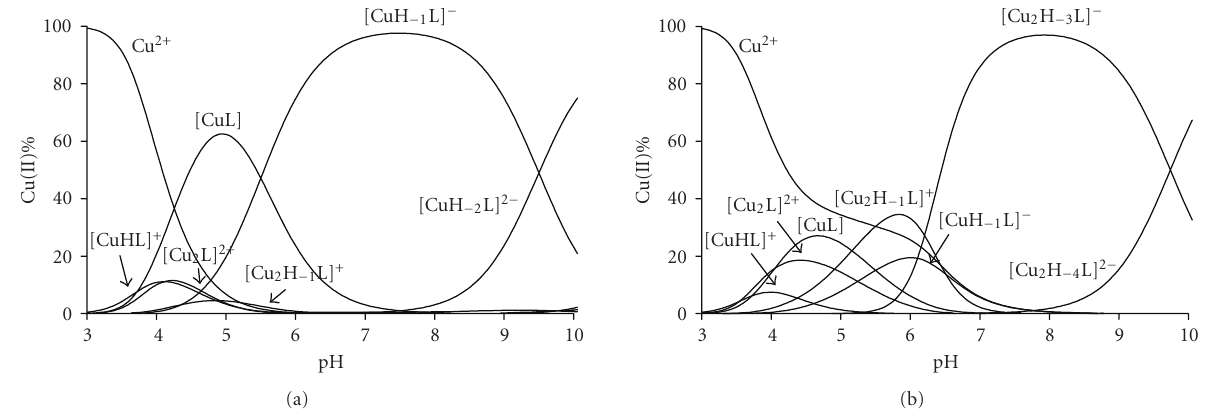
Figure 2: Metal ion speciation of the copper(II)-FDAH system in (a) equimolar samples and (b) at 2 : 1 metal to ligand ratio (c L = 2 · 10 − 3 mol/dm 3 ).